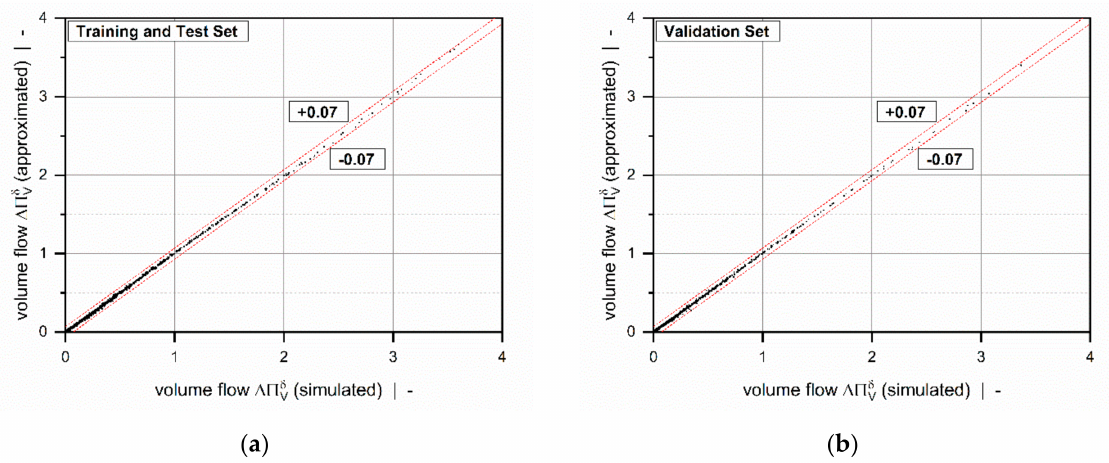
(cid:16) (cid:17) = f t / D b , n , Π δ p , x : training and test set ( a ) and validation set ( b ). The dashed lines V